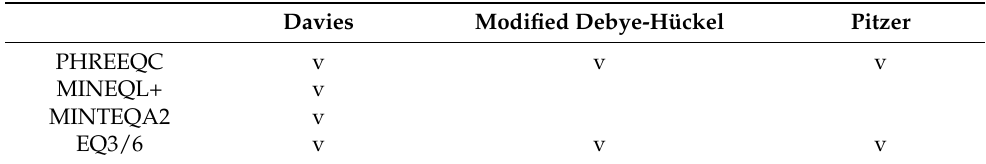
Table 7. Options of activity coefficient equations incorporated with four